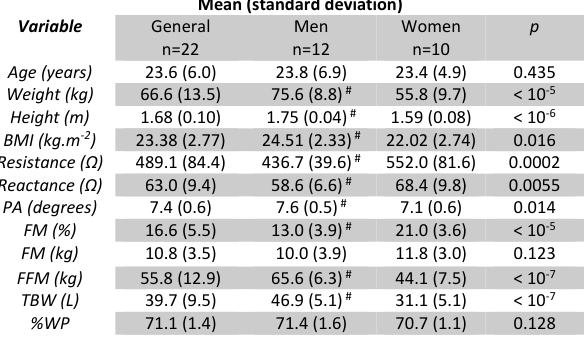
Table 1: Data from the anthropometric assessment of high-performance karate athletes.